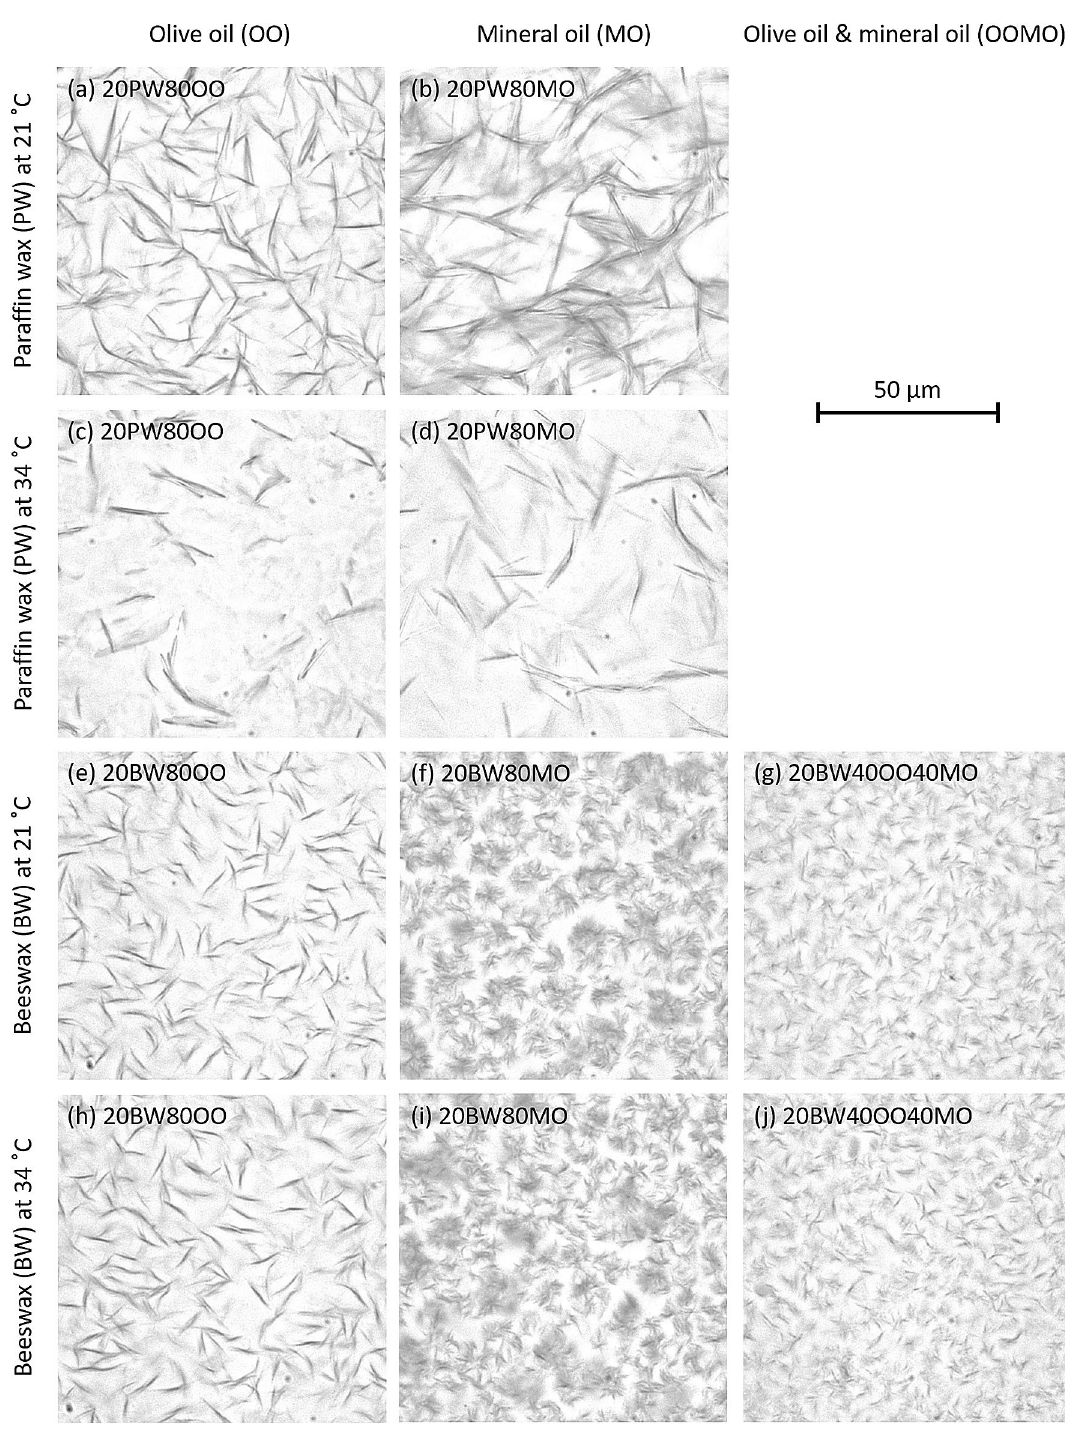
Figure 5. Microstructures of various wax-oil lubricants at 20 wt% wax and 80 wt% oil at 21 °C (room temperature) and 34 °C (skin surface temperature). As a naming convention for the various mixtures, the weight percent of each component is listed in front of the specific component, e.g., 20BW80MO represents a 20 wt% beeswax and 80 wt% mineral oil